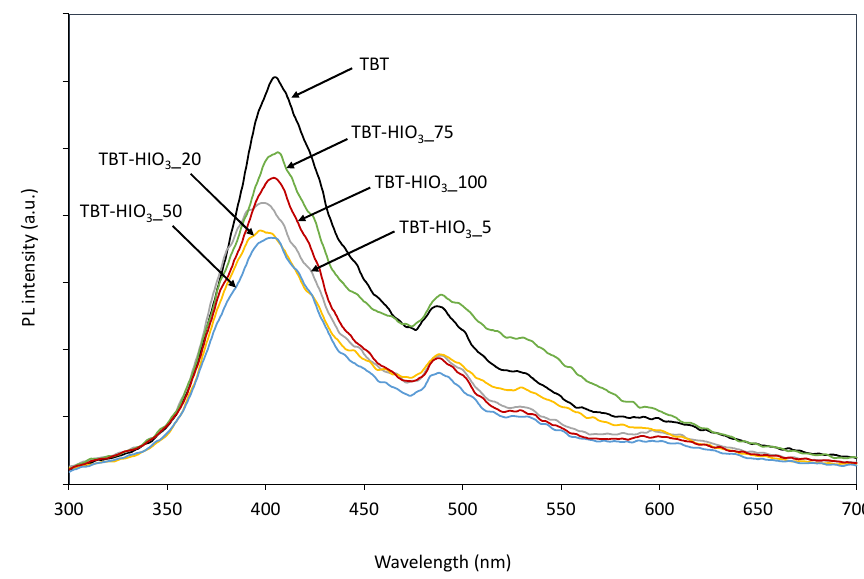
Figure 10. Photoluminescence (PL) spectra for defective TiO 2 -HIO 3 samples. Figure 10 . Photoluminescence (PL) spectra for defective TiO 2 -HIO 3 samples.